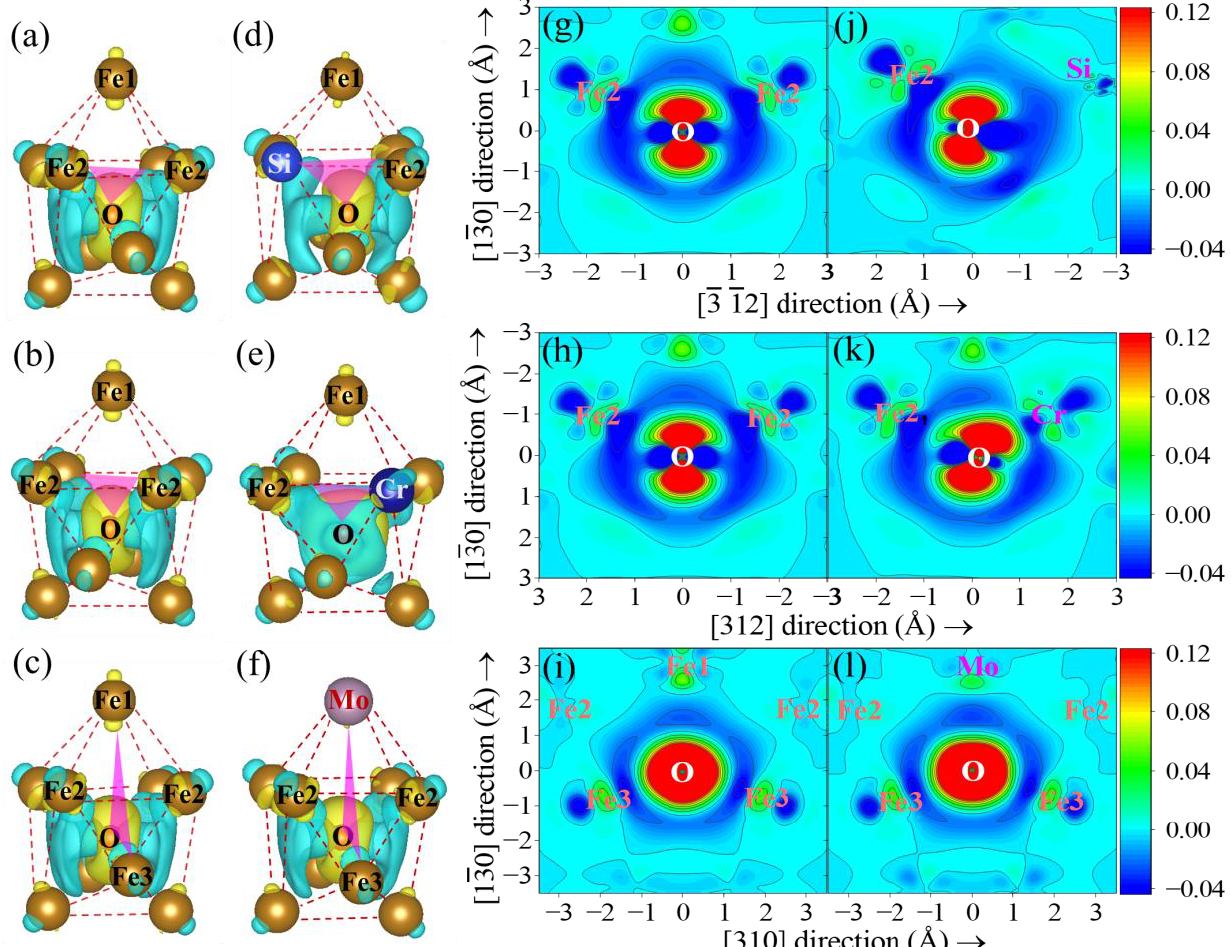
Figure 6. The differential charge densities of O in pure Fe, Si, Mo and Cr alloyed iron in three-dimensions ( a – f ) and in two-dimensions ( g – l ). ( a – c ) show the differential charge densities of CTP in a pure Fe-GB in three-dimensions with different projections for the comparison with the alloyed GBs in the right plots ( d – f ). In ( a – f ), the yellow area indicates charge accumulation, and the blue area indicates charge loss. In ( g – l ), the negative value in the blue region indicates the loss of charge density, while the positive value in the red region corresponds to the accumulation of charge density. The isosurface of 0.005 was used when intercepting the two-dimensional projection